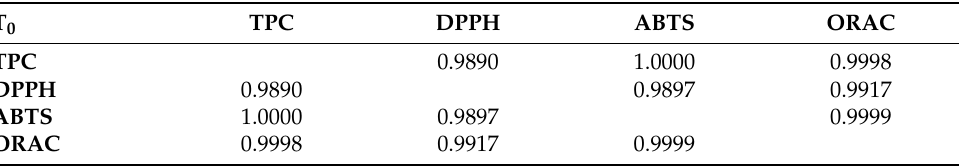
Table 1. Correlation coefficients (R 2 ) between total phenolic content (TPC), DPPH, ABTS, and ORAC assays at T 0 and T 1